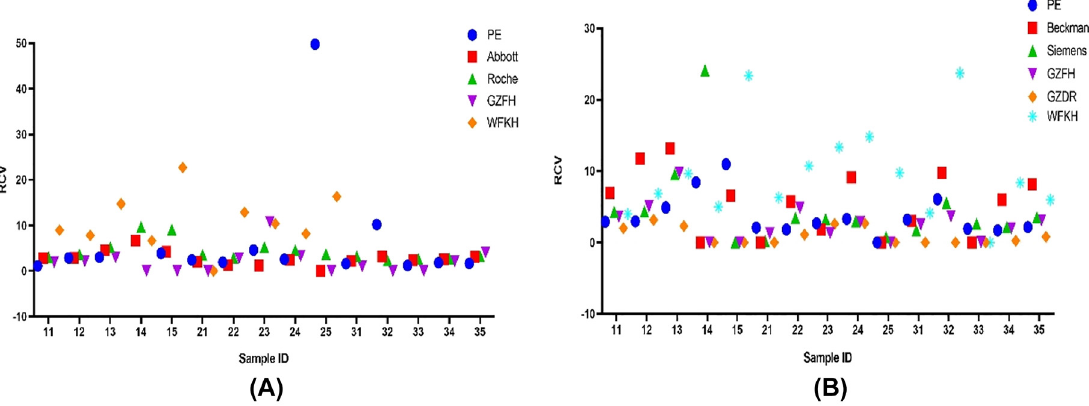
Figure 1: Acceptable percentage of different performance specifications of different platforms. Orange bars represents optimum performance; yellow bars represents desirable performance; green bars represents minimum performance.